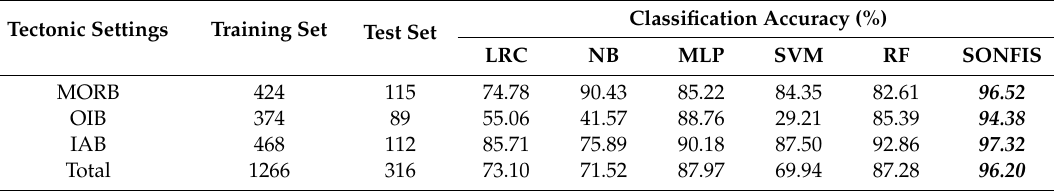
Marked in italics and bold denotes the classification accuracy of the best classifier for different tectonic settings. Table 5. Classification accuracy of tectonic discrimination of basalts in dataset 2 based on six MLAs. Tectonic Settings